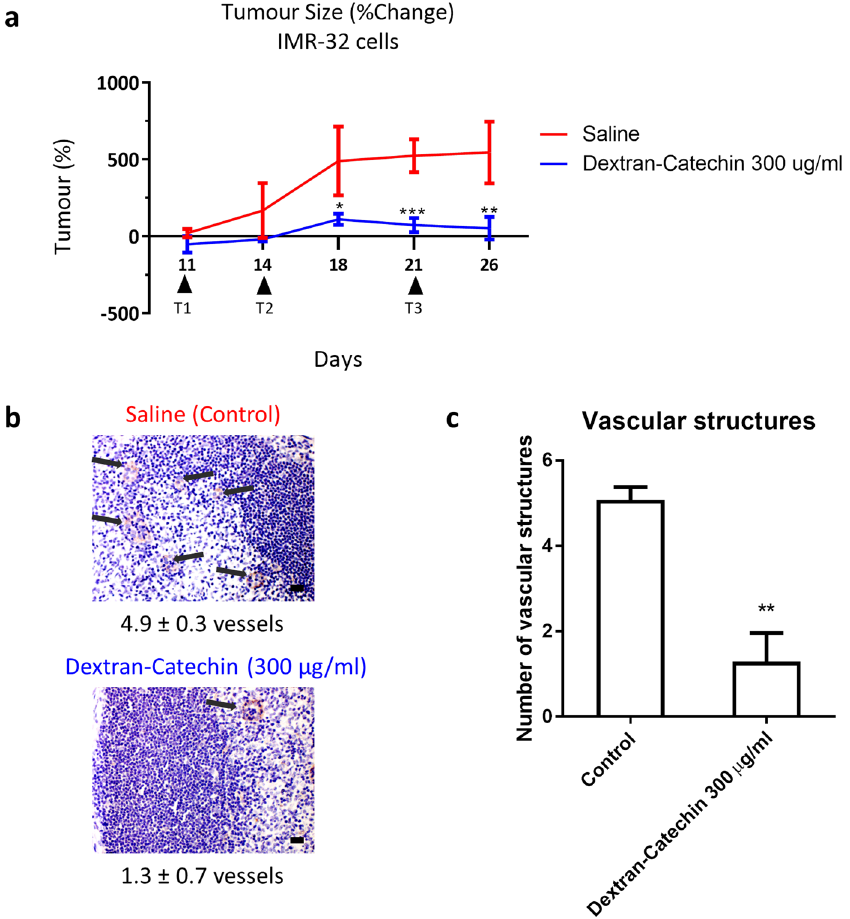
Dextran-Catechin when the mean tumor volume reached about 200 mm 3 . Treatment administered i.v. weekly for three weeks significantly reduced tumor growth in mice treated with 300 μ g/ml Dextran-Catechin compared to the saline control cohort. ( a ) Graph of tumor size changes between control and treatment group. Lines, n = 4; Bars, SEM ( * p < 0.05, ** p < 0.01, *** p < 0.001). ( b ) Representative photographs of endothelial cells